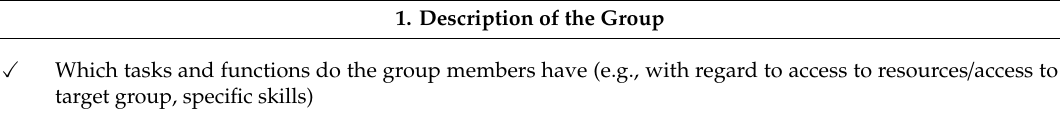
Table 2. Questions for monitoring capacity building in the